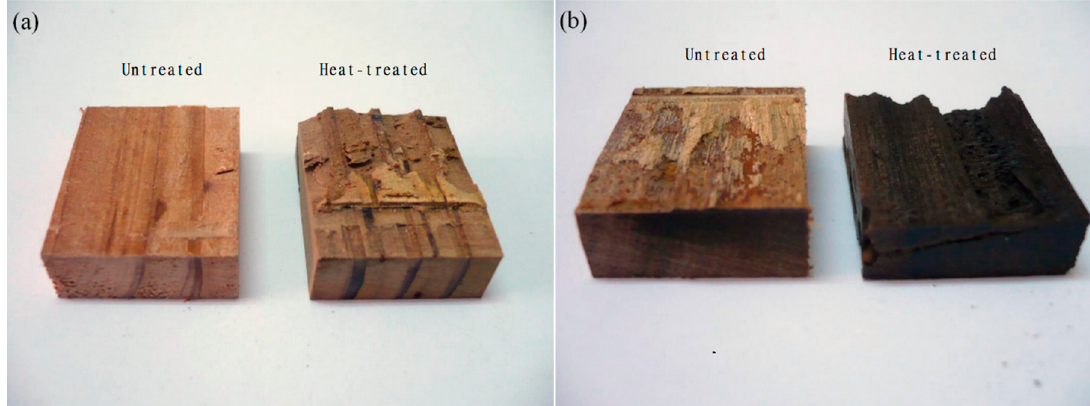
Figure 3. Appearance of untreated and heat-treated Japanese cedar ( Cryptomeria japonica D. Don) ( a ) and Formosa acacia ( Acacia confuse Merr.(Leguminosae)) ( b ) wood with urea-formaldehyde resin (UF) adhesive after the shear strength test.